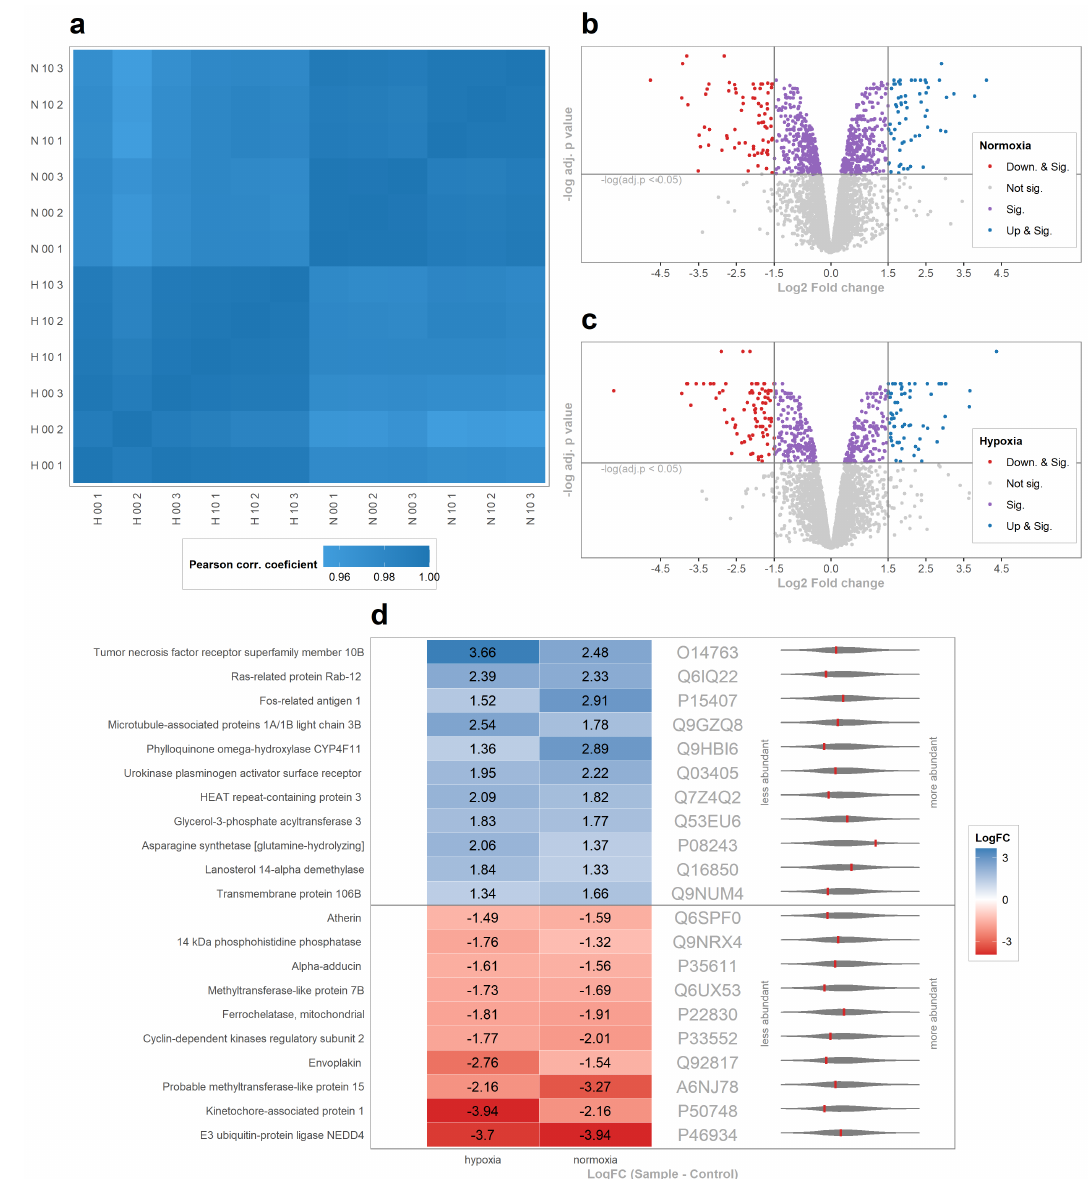
Figure 4. Result from the mass spectrometry (MS) analysis of the HCT 116 cells after 48 h treatment with 10 µ M SKR. ( a ) Heatmap of all calculated Pearson’s correlation coefficients within all samples (hypoxia is marked by H, normoxia by N and 00 and 10 are control and 10 µ M SKR samples, respectively). The last number (1–3) indicates the specific repetition. ( b , c ) Volcano plots of all protein groups in the samples as a comparison between control and treated samples in hypoxia and normoxia, respectively. On x axes are the Log2 Fold change values of protein groups between control and 10 µ M SKR samples. The threshold for the significance of the protein group is an adj.p value lower than 0.05. ( d ) Heatmap of significantly upregulated (blue) and downregulated (red) protein groups in both conditions (hypoxia on the left and normoxia on the right) with UniProt accession numbers. Red lines in violin plots of all protein group intensity distributions represent the relative abundance of a protein group (more abundant on